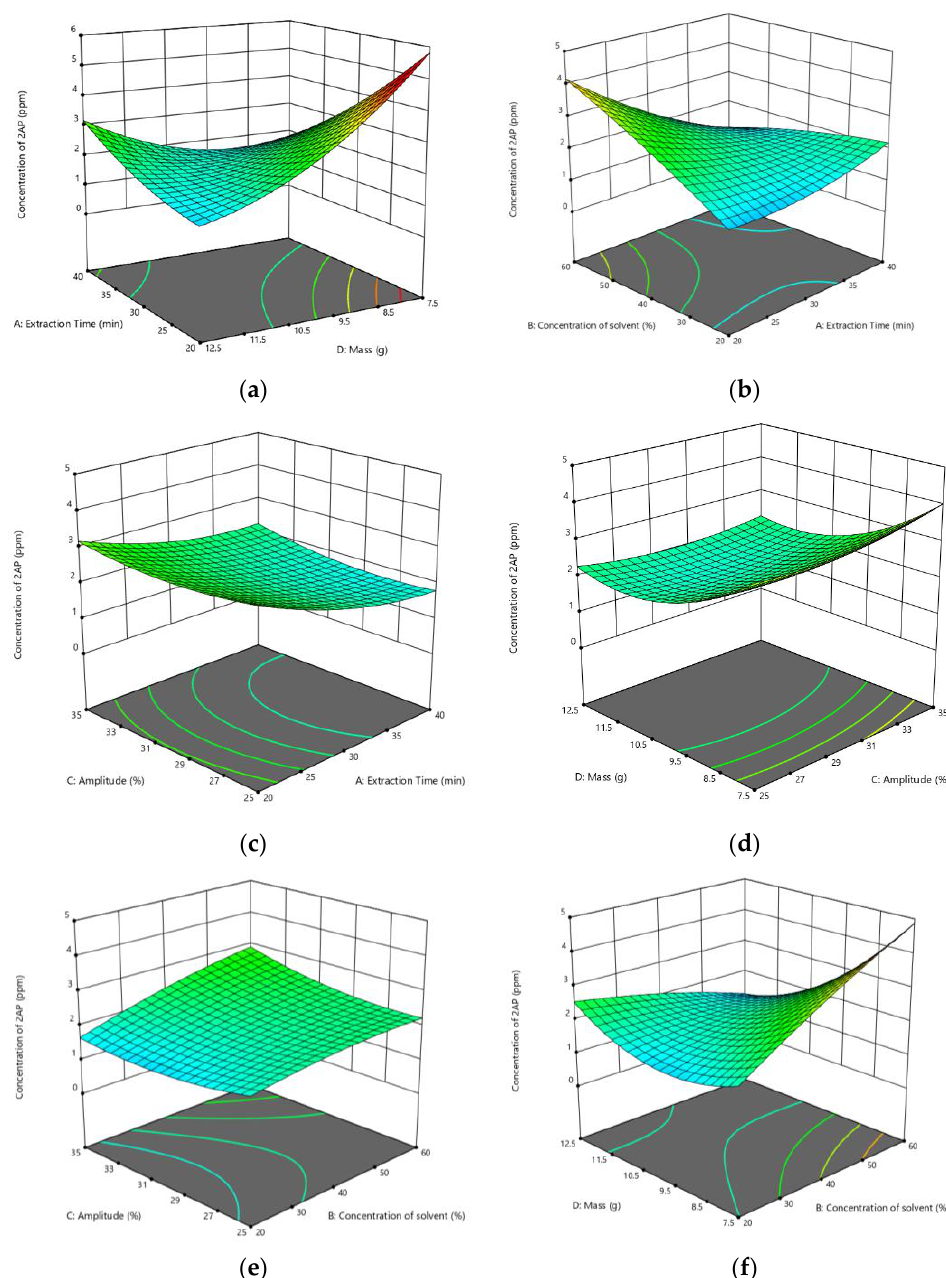
Figure 3. 3D response surface plots representing the effect of response variables on the concentration of 2AP obtained from pandan extract; ( a ) Effect of mass of leaves and extraction time towards concentration of 2AP; ( b ) Effect of concentration of solvent and extraction time towards the concentration of 2AP; ( c ) Effect of sonication amplitude and extraction time towards concentration of 2AP; ( d ) Effect of mass of leaves and sonication amplitude towards concentration of 2AP; ( e ) Effect of sonication amplitude towards concentration of 2AP; ( f ) Effect of mass of leaves and concentration of solvent towards concentration of